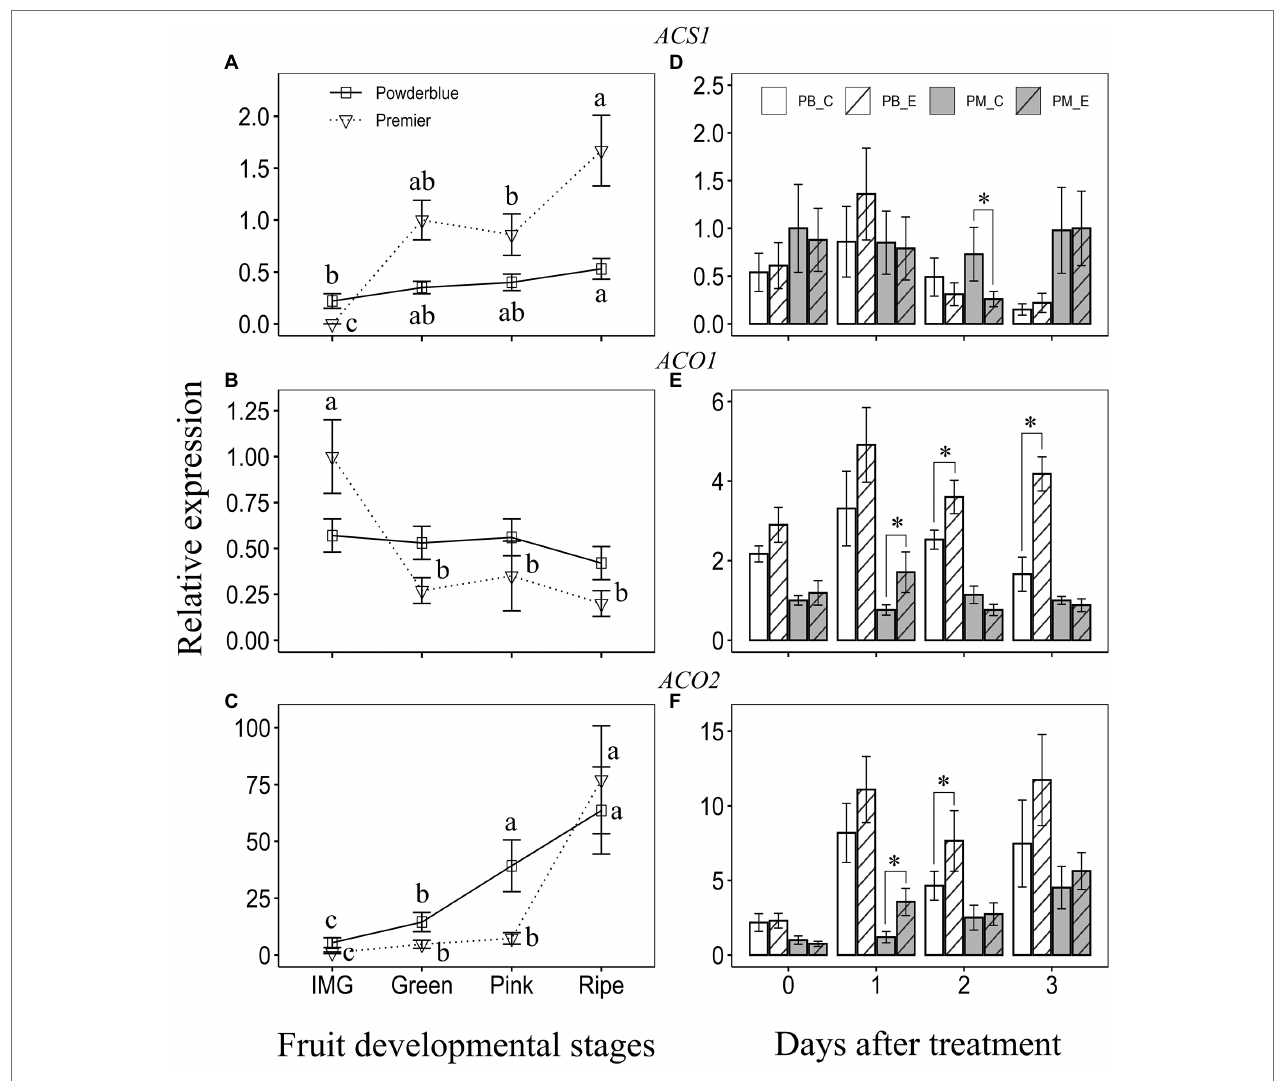
FIGURE 4 | Transcript abundance of ethylene biosynthesis genes: 1-aminocyclopropane-1-carboxylic acid synthase ( ACS ; A,D ), and 1-aminocyclopropane-1- carboxylic acid oxidase ( ACO ), ACO1 (B,E) , and ACO2 (C,F) during ripening (left panels) and treatment with water (control) and 250 ppm ethephon (right panels). IMG, Immature Green; PB_C, Powderblue control; PB_E, Powderblue ethephon; PM_C, Premier control; and PM_E, Premier ethephon. Different letters above symbols indicate that the means are significantly different across fruit developmental stages (within a cultivar) according to ANOVA and Tukey’s HSD ( α = 0.05). Asterisk indicates the means are significantly different between treatments (control and ethephon), within a cultivar and given date, according to t- test ( α =